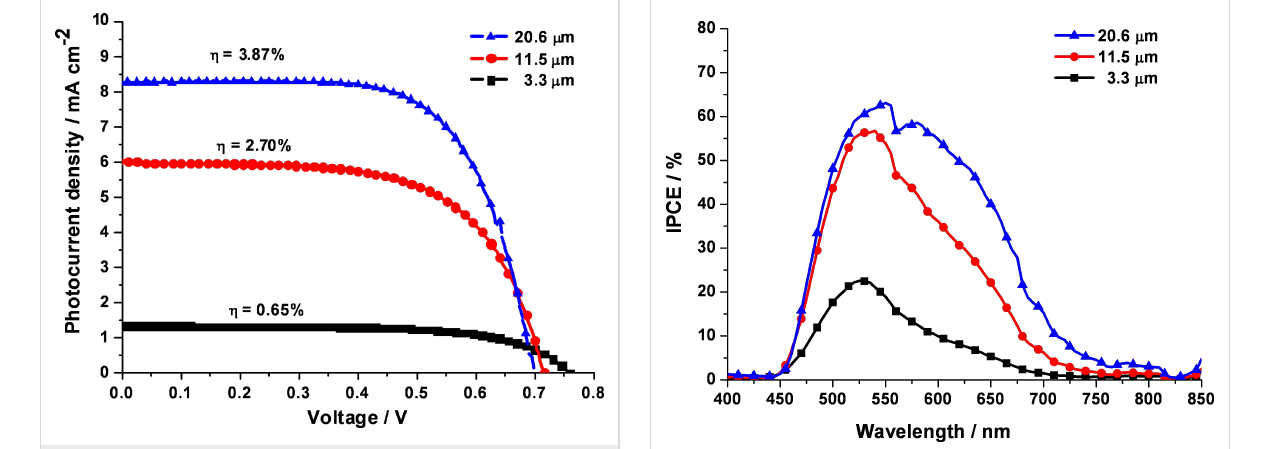
ment was performed on the samples characterized in Figure